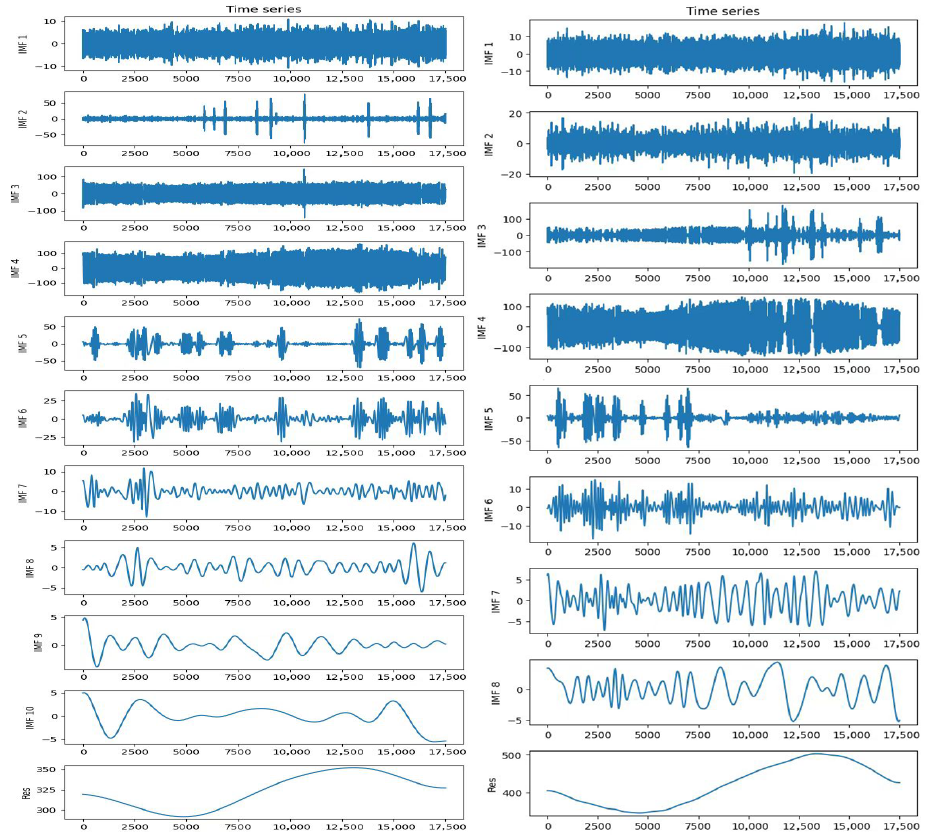
Figure 7. Mode decomposition spectrogram.